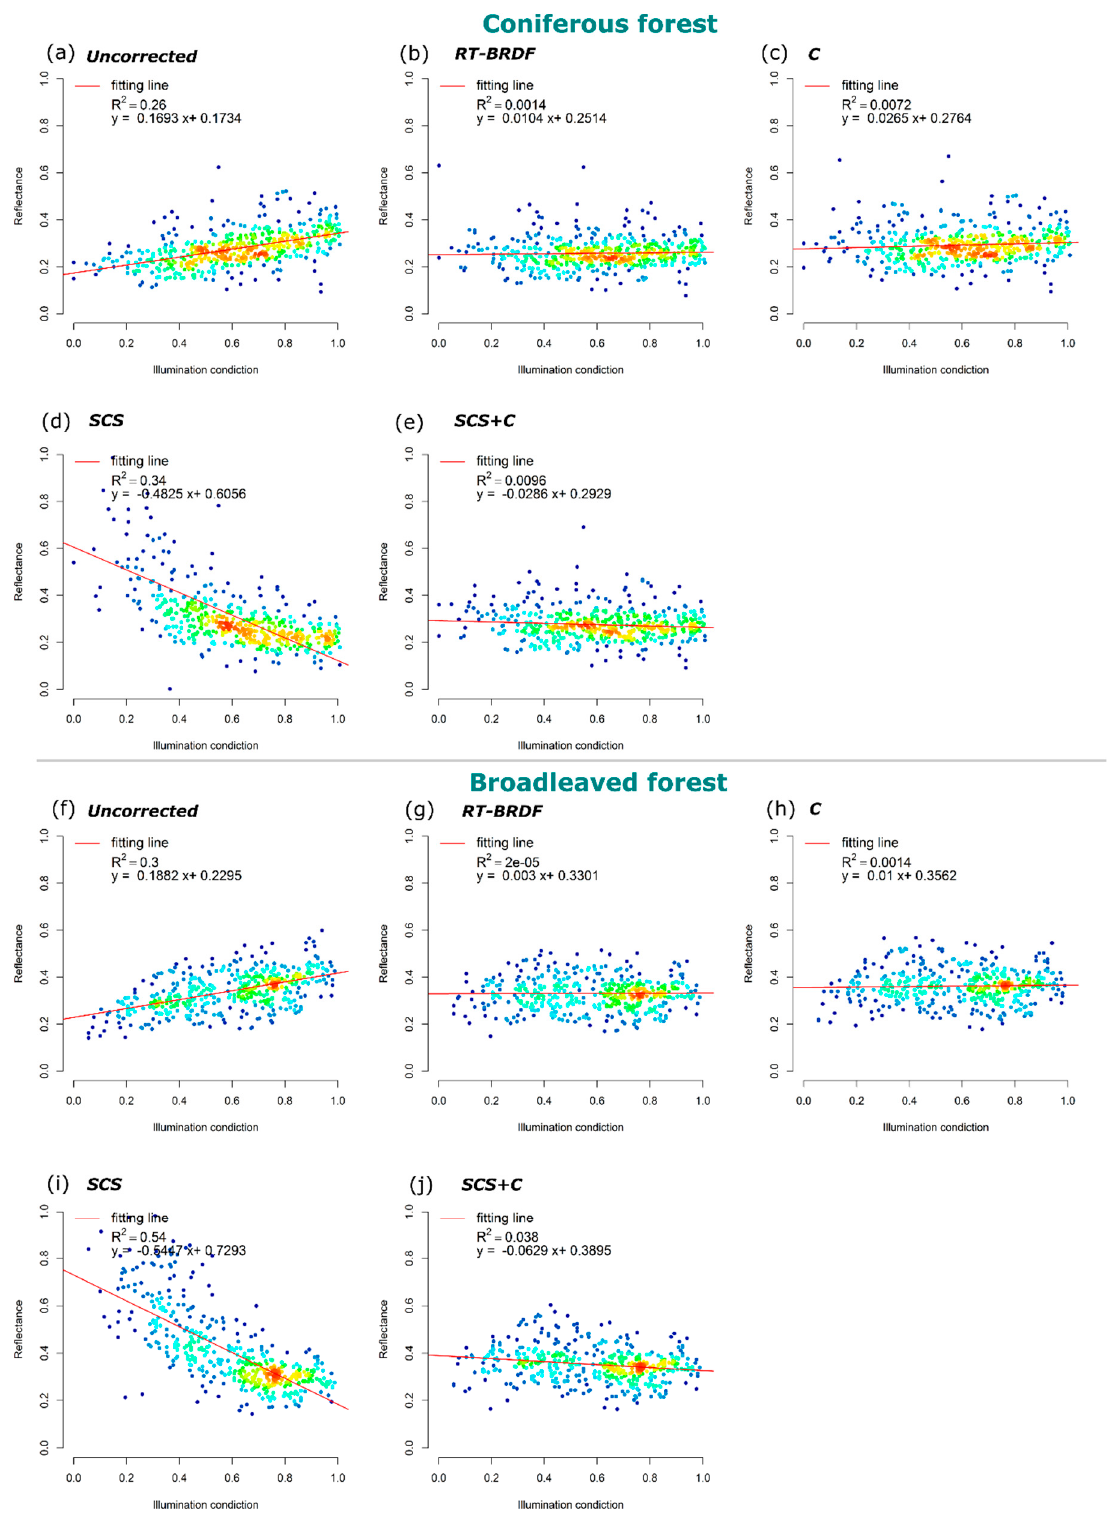
Figure 7. Density scatterplots of the relationship between illumination conditions and reflectance at 837.19 nm for coniferous ( a – e ) and broadleaved ( f – j ) forest. ( a ) Uncorrected, ( b ) RT-BRDF, ( c ) C, ( d ) SCS, and ( e ) SCS + C corrected reflectance values of coniferous forest pixels; ( f ) uncorrected, ( g ) RT-BRDF, ( h ) C, ( i ) SCS, and ( j ) SCS + C corrected reflectance values of broadleaved forest pixels.